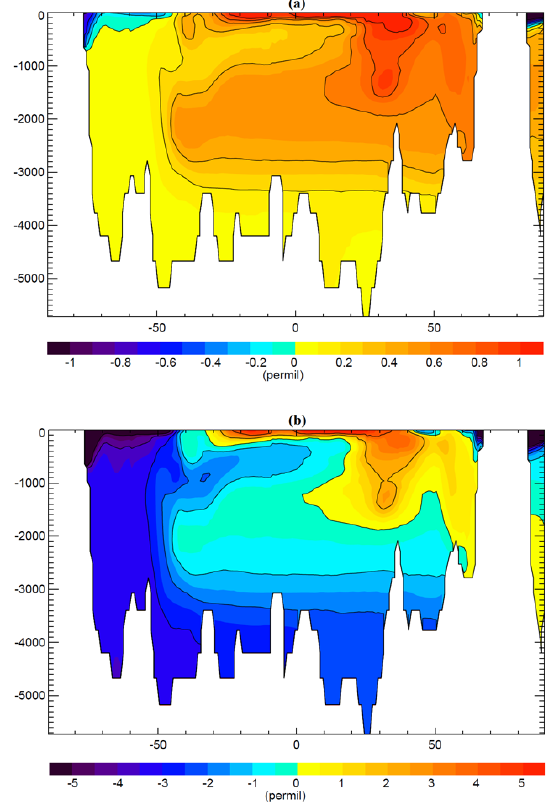
Fig. 5. MPIOM simulation results: (a) The annual zonal mean δ 18 O of the Atlantic basin. (b) The annual zonal mean δ D of the Atlantic basin.